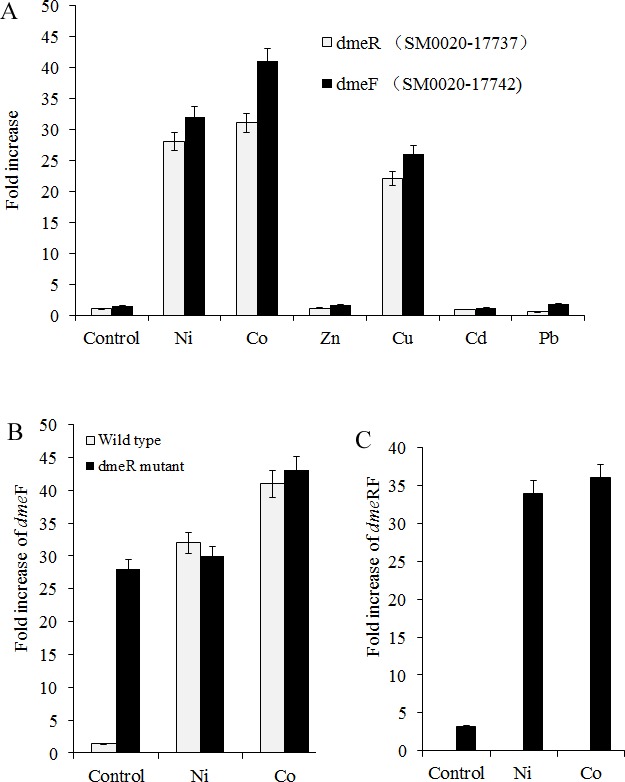
dmeFR PCR analysis.Induction of dmeF and dmeR of wild type or dmeR mutant by various metals examined through quantitative real-time PCR analysis. Wild type and dmeR mutants of S. meliloti CCNWSX0020 strains at OD600 of 1.0 were incubated with 0.5 mM CuSO4, ZnCl2, Pb(NO3)2, NiCl2, 0.2 mM CdCl2 and 0.3 mM CoCl2 for 30 min. The fold changes in dmeF and demR expression are expressed relative to the untreated control. Samples were then processed for qPCR analysis and normalized against the ribosomal 16 S rRNA. Error bars represent standard deviations of three biological repeats.